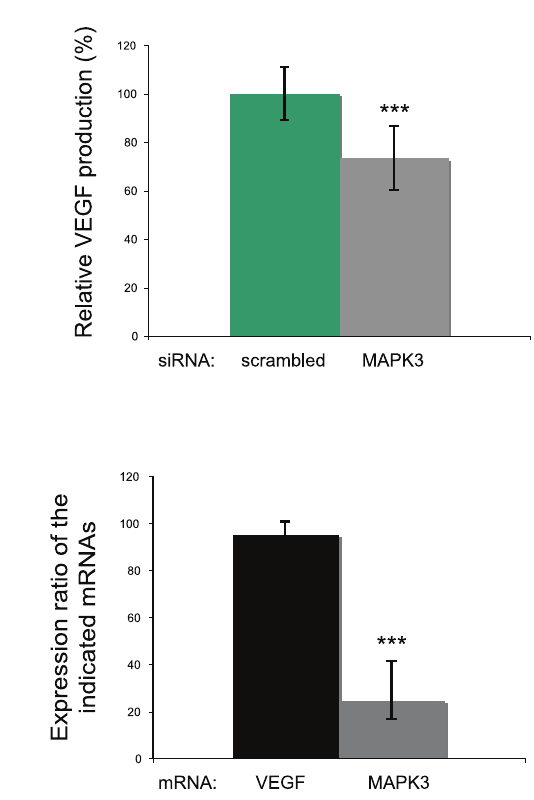
Figure 5. MAPK3 specifically regulates endogenous VEGF expression without affecting mRNA stability. (a) Determination of endogenous VEGF by ELISA . Error bars represent standard deviations calculated from 3 independent experiments, each performed at least in duplicates. Statistical analysis of differences between controls and experimental samples were performed with the Microsoft Excel unpaired, type 2, Student’s t test. (b) Endogenous VEGF and MAPK3 mRNA levels measured by qRT-PCR. The expression ratio of the indicated endogenous mRNAs (VEGF and MAPK3) in MAPK3 siRNA- treated cells relative to scramble siRNA treated cells (%) is shown. Statistical analysis of differences between controls and experimental samples were performed with the Microsoft Excel unpaired, type 2, Student’s t test. A p-value of . 0.5 and , 0.05 was determined for VEGF and MAPK3, respectively. Relative VEGF and MAPK3 mRNA levels, standard deviations and statistical significance were calculated with REST 2009 software as described in ‘‘Material and